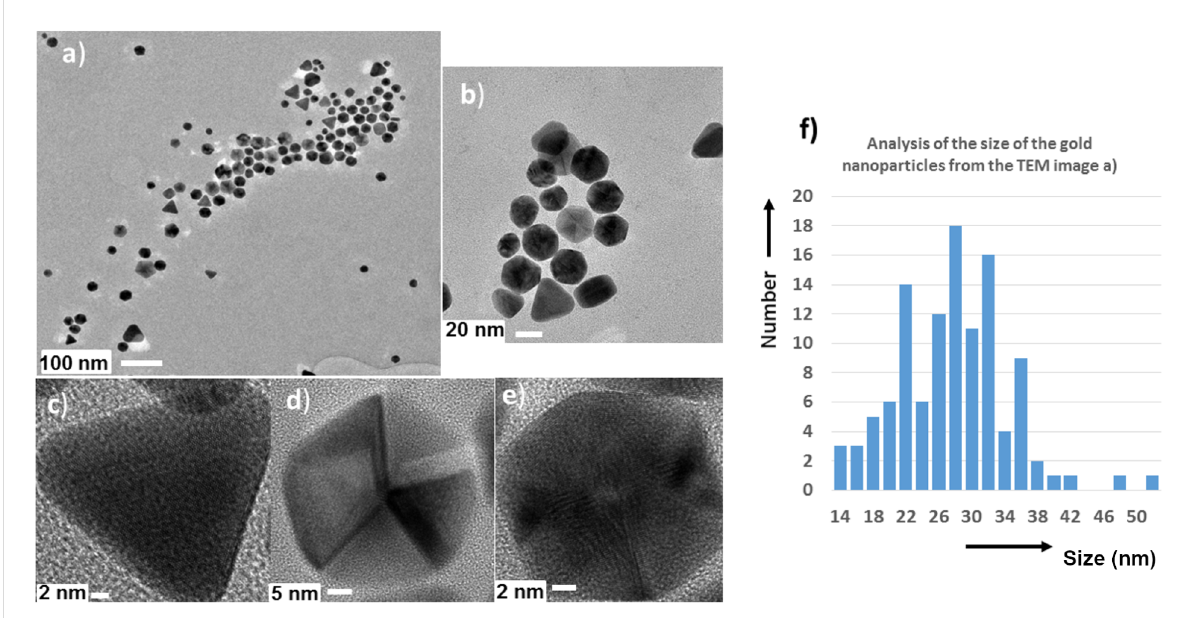
Figure 3: (a–e) TEM images of the gold nanoparticles obtained from the dendrimer compound 4 at different magnifications. (f) Analysis of the size dis- tribution of the gold NPs from the TEM image (a). Scale bars: 100 nm (a), 20 nm (b), 2 nm (c and e) and 5 nm (d).